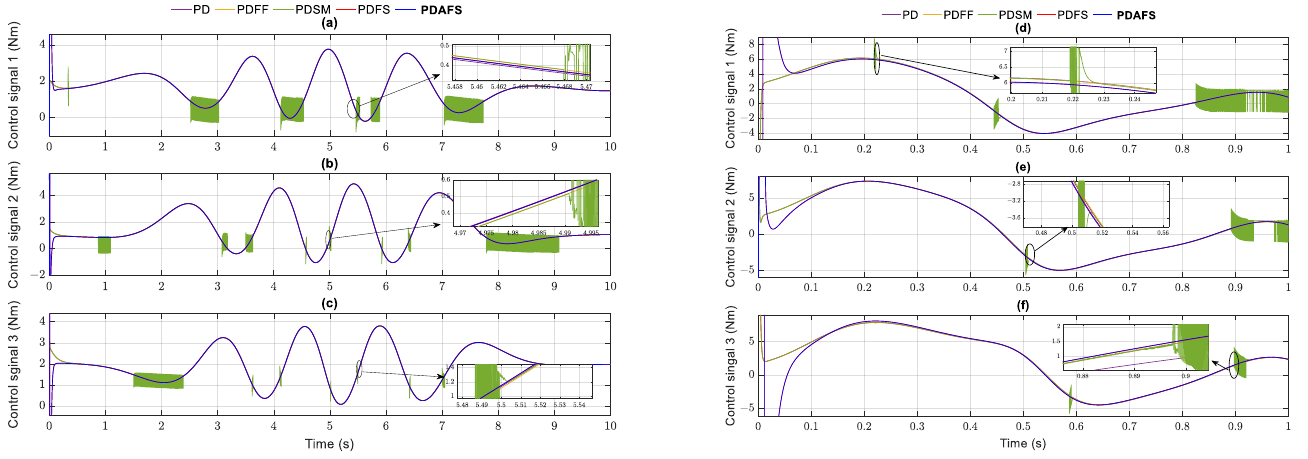
Figure 8. Control signals generated by the controllers in the helix simulation and parabolic simulation: ( a ) control signal of joint 1; ( b ) control signal of joint 2; ( c ) control signal of joint 3 in the helix case; ( d ) error of joint 1; ( e ) error of joint 2; ( f ) error of joint 3 of the parabolic case.